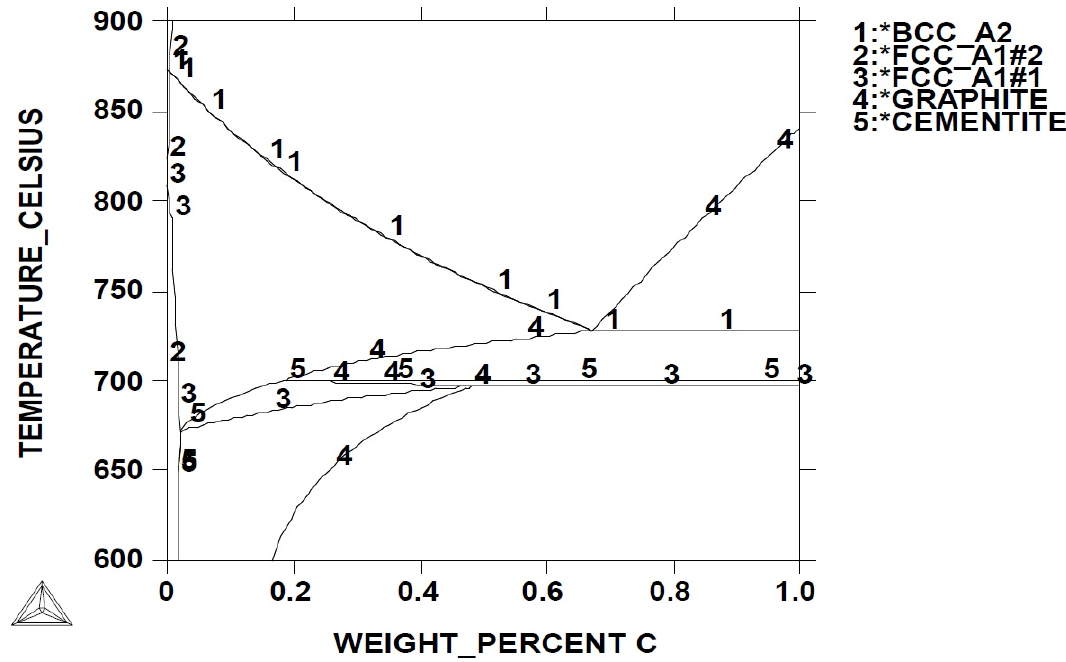
Figure 3. Thermal cycles simulating two welding passes to generate the IC CGHAZ zone. These thermal cycles were designed to obtain the microstructure of a heat affected zone (HAZ) from two welding passes. The first pass reaches a coarse-grained heat affected zone and the second pass pertains to an intercritical zone (IC CGHAZ). The temperature of the second intercritical pass, which was 800 °C, was taken between the temperatures AC1 = 695 °C and AC3 = 830 °C calculated with the Thermo-Calc ® (Thermo-Calc Soft- ware’s, Pittsburgh, USA) version 1 thermodynamic software based on TCS Steel and Fe-alloys Database (TCFE) data (Figure 4).